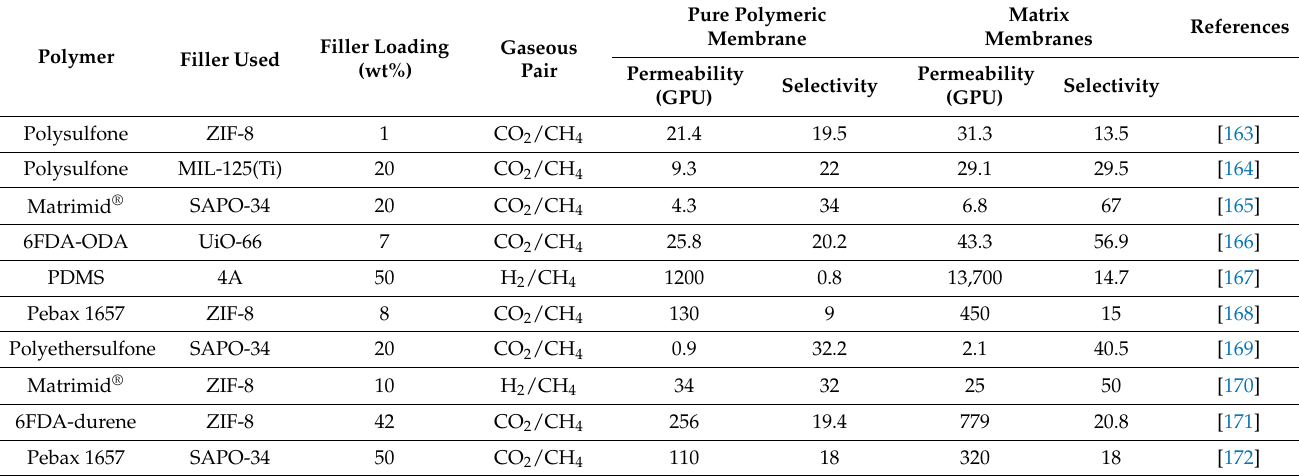
Table 6. Gas separation performance of MMMs in comparison to pristine polymeric